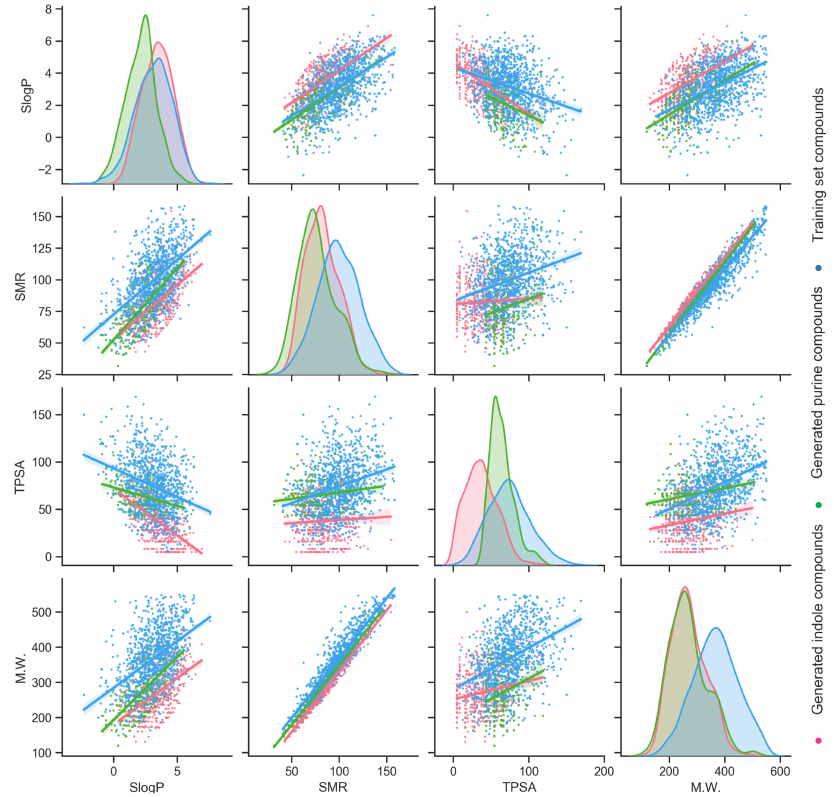
Figure 4. Distribution and correlation of molecular weight (M.W.), topological polar surface area (TPSA), molecular refractivity (SMR), and log of the octanol/water partition coefficient (SlogP) for training compounds, generated indole compounds, and generated purine